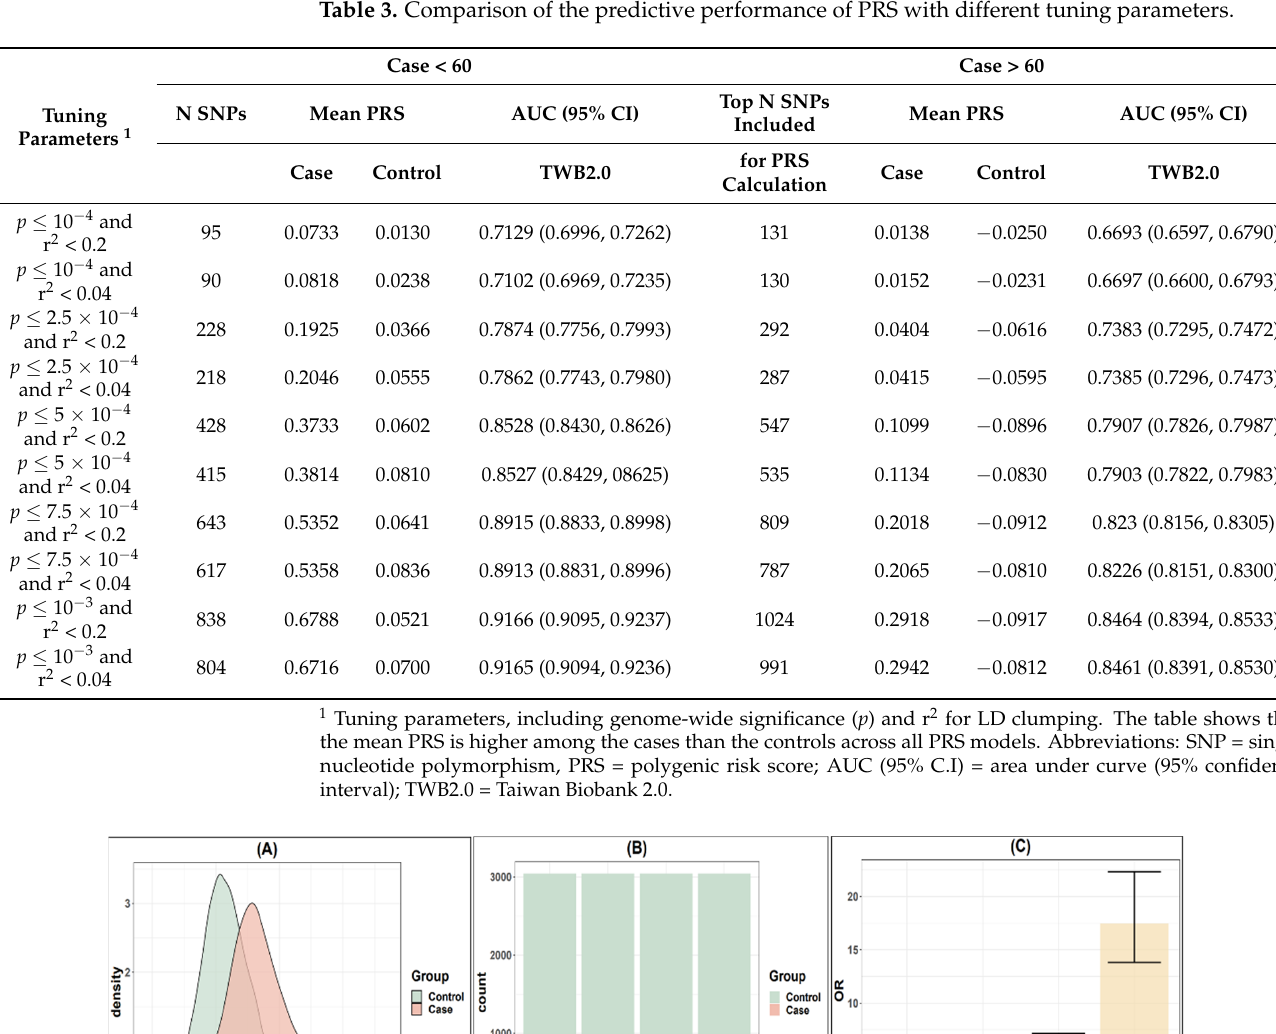
Table 3. Comparison of the predictive performance of PRS with different tuning parameters.